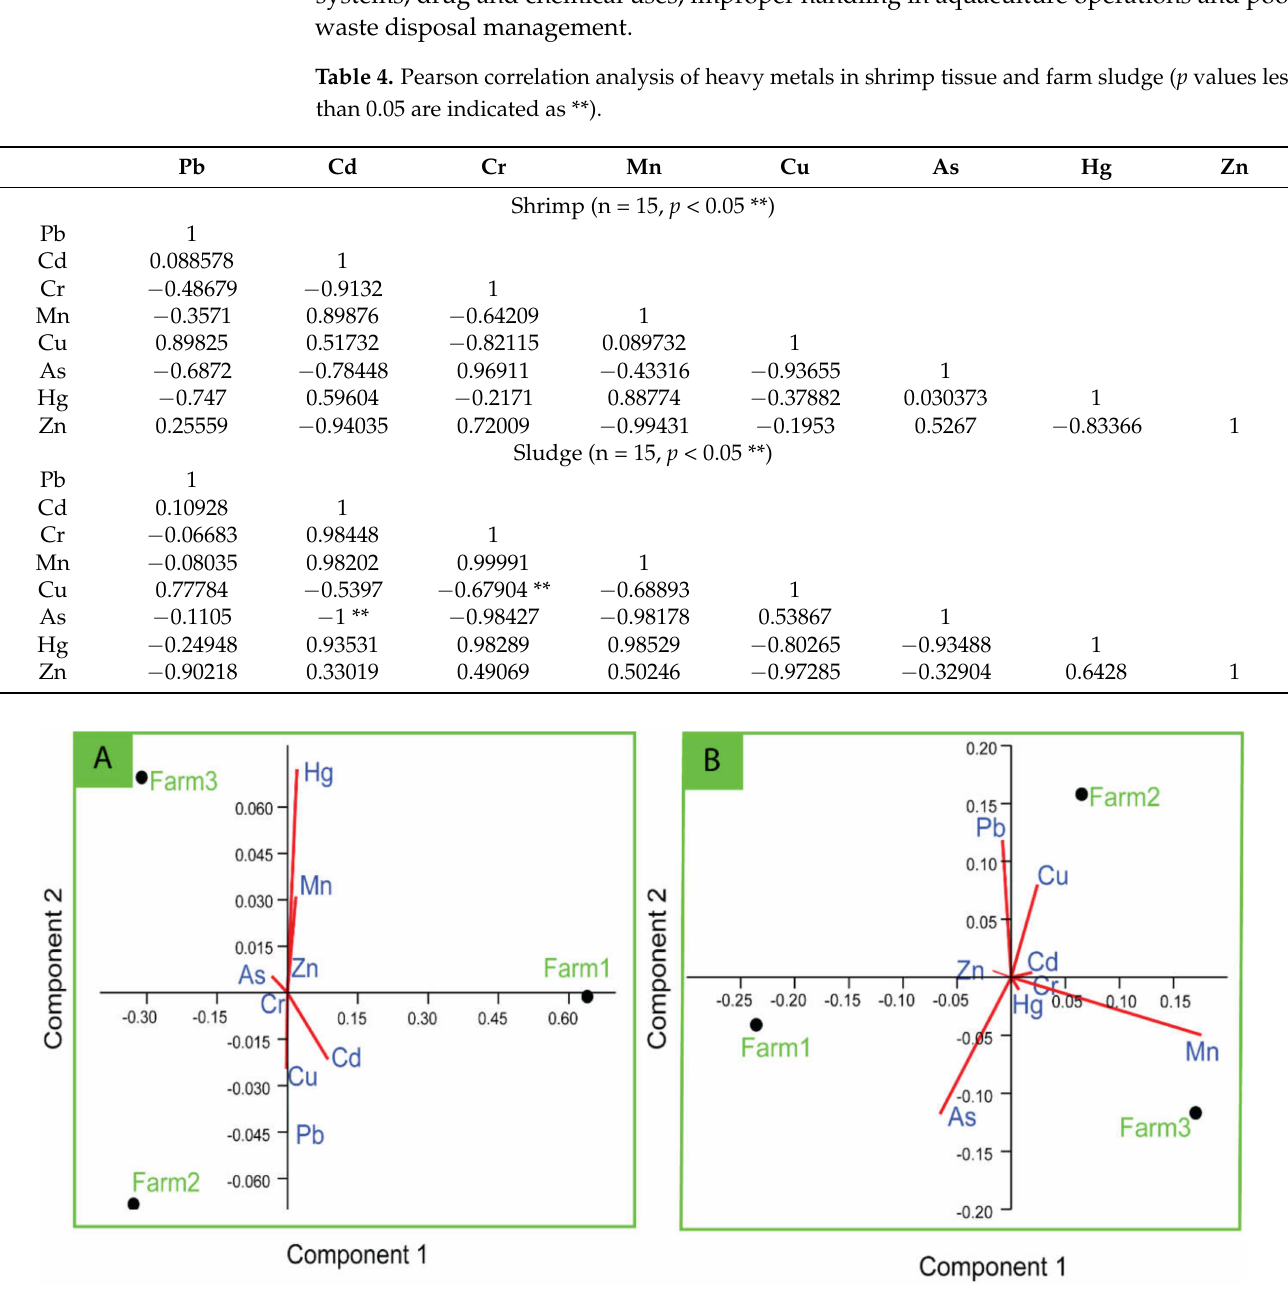
Figure 4. Principal component analysis (PCA) biplot of log-transformed metal concentration in shrimp tissue ( A ) and farm sludge ( B